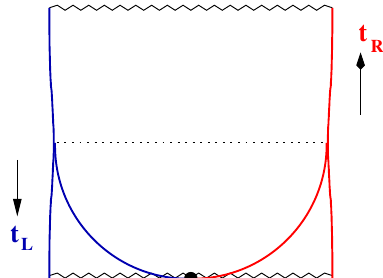
Figure 4 . The combination of the Lorentzian and the Euclidean geometries is depicted. This is used to construct a thermo(cid:12)eld initial state and subsequent Lorentzian time evolution. at the same time. In this (cid:12)gure, we draw only the lower half of Euclidean evolution which is relevant to the initial ket